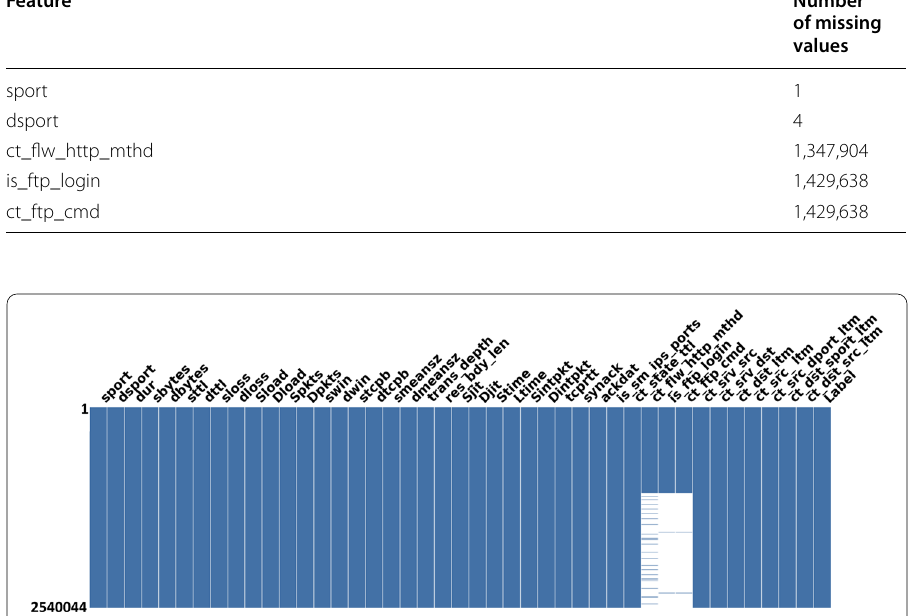
Fig. 2 Missing values matrix. Missing values in complete data-set from all features are shown in the figure. Blanks in a bar of a feature show missing values. Major portion of missing values comes from ct_flw_http_ mthd, is_ftp_login and